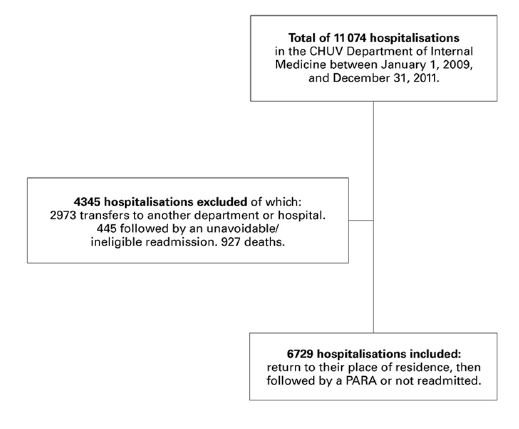
Figure 1: Details of hospitalisations included in and excluded from the analysis to develop a risk prediction model for potentially avoidable readmission